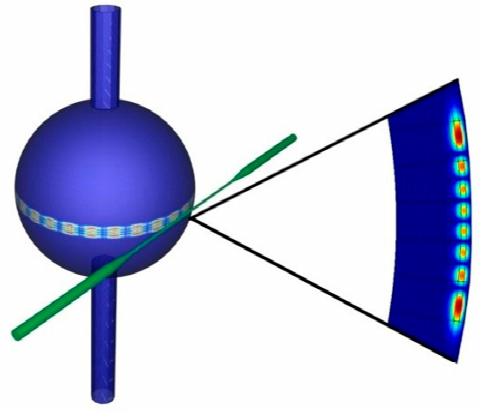
Figure 1. Three dimensional render image of an OMBR coupled with a fiber taper. An example of field intensity cross section on the hollow WGM microcavity surface is reported for n = 1 and l − | m | + 1 = 8.